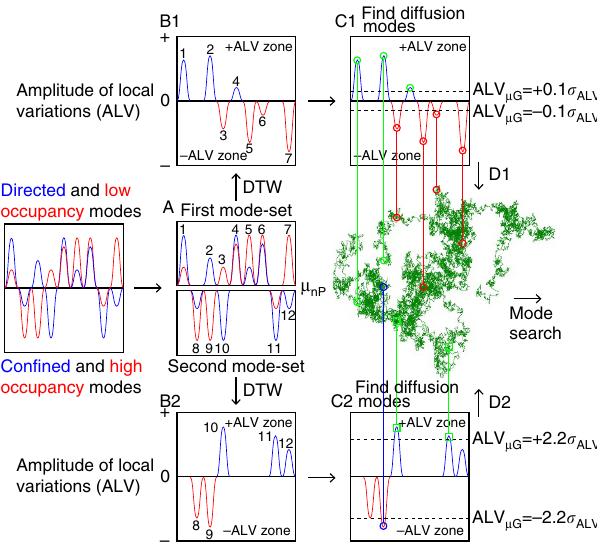
Figure 5 | Analysis of the sub-modes of diffusion. Schematic illustration of the four-step analyses of the sub-modes of diffusion.